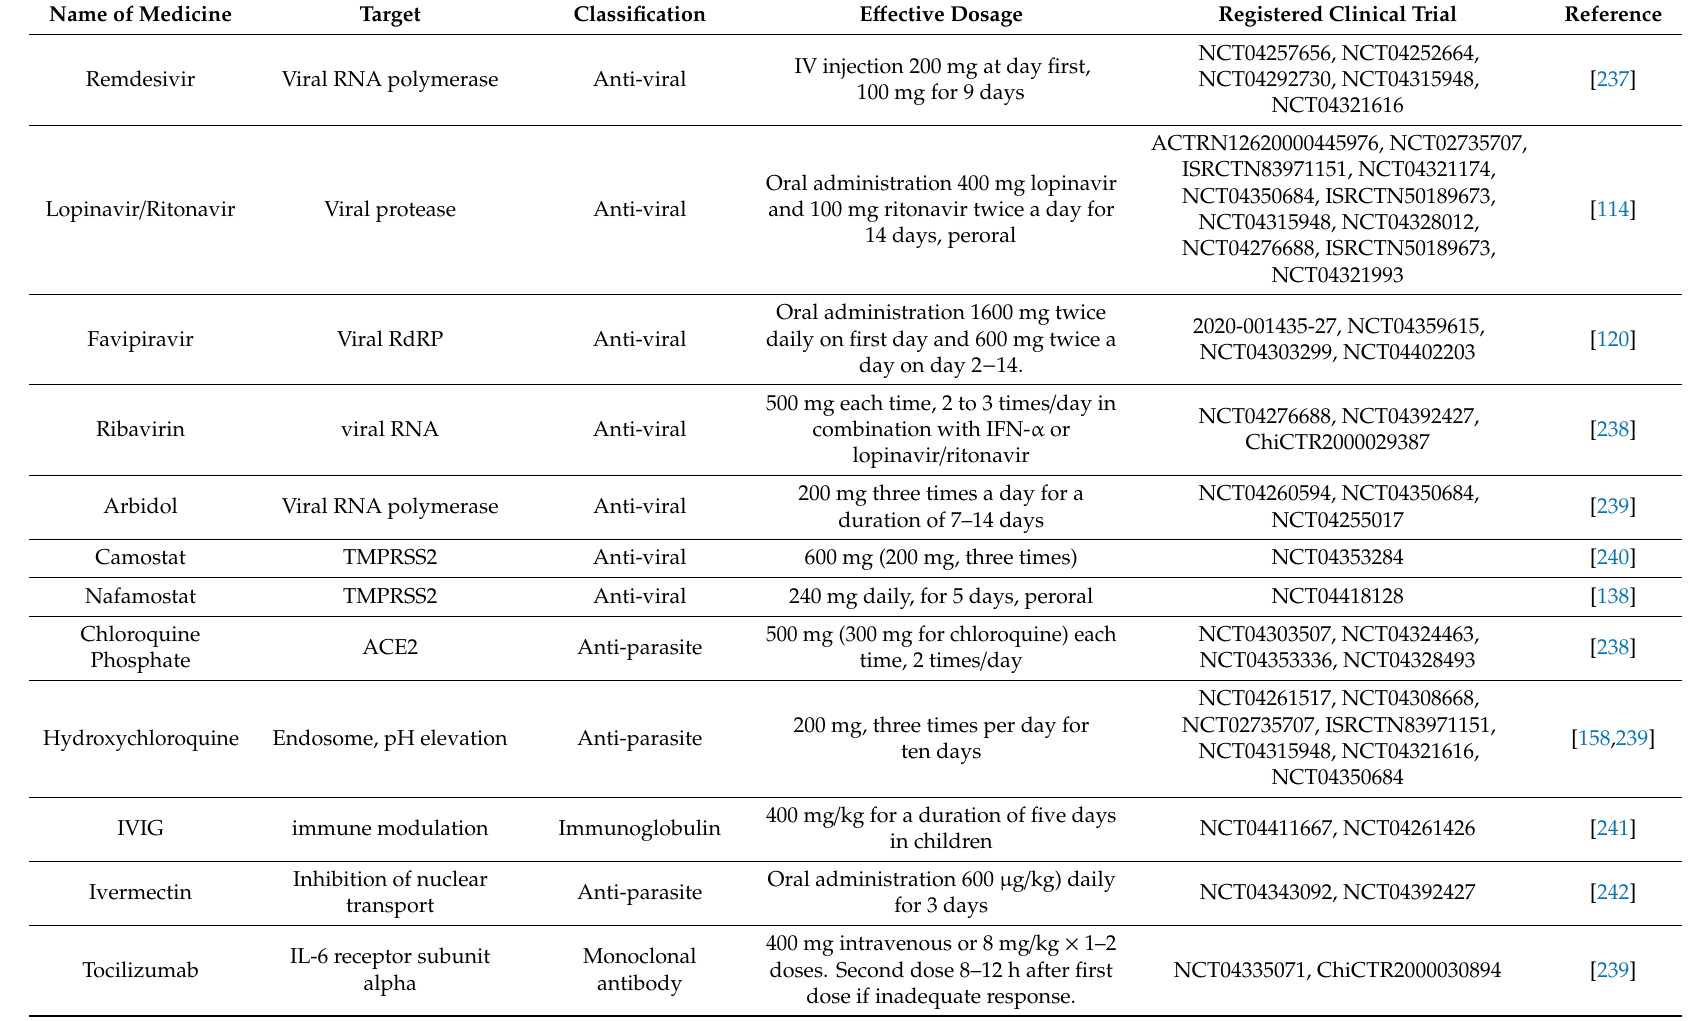
Table 1. List of available drugs targeting SARS-CoV-2 infection and their e ff ective